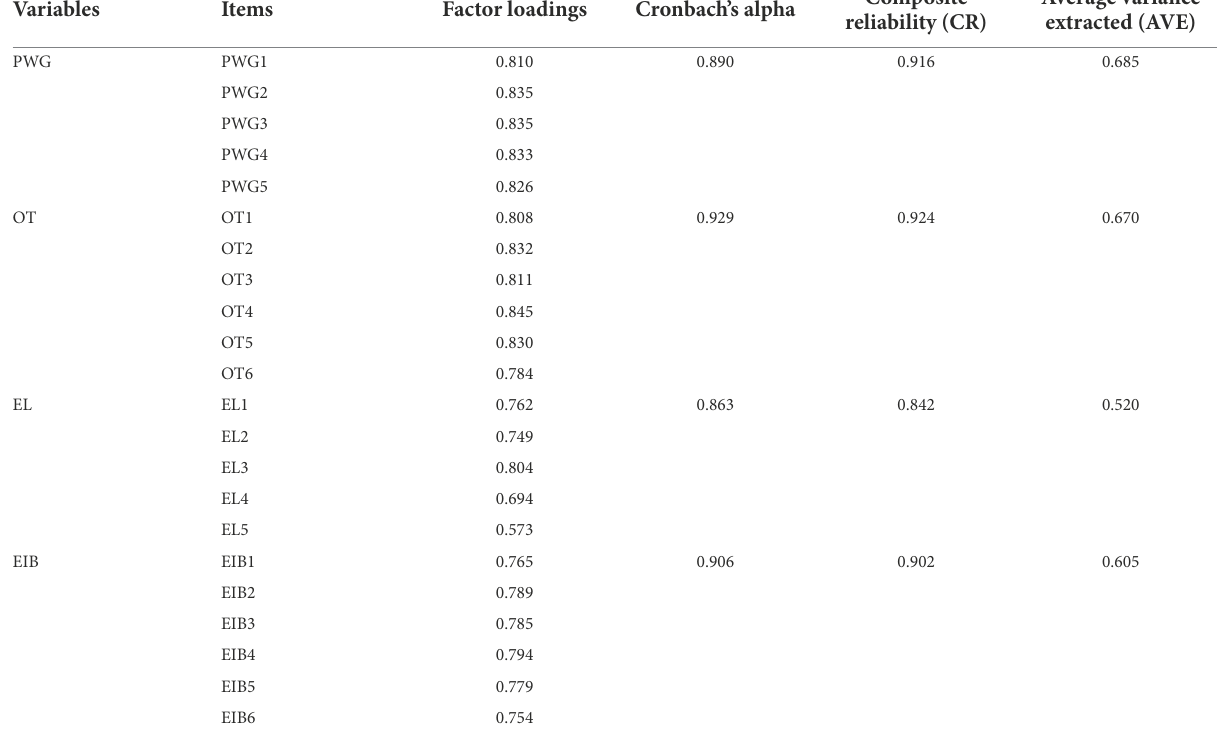
TABLE 1 Factor loadings of variables and overall reliability.